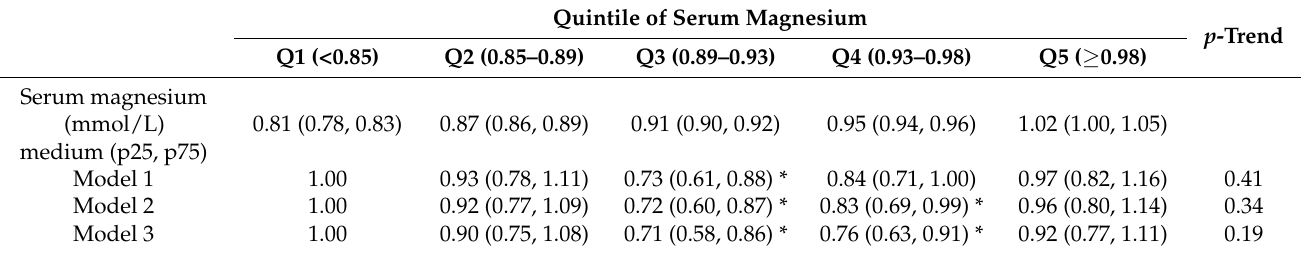
Table 2. Hazard ratio (HR) and 95% confidence interval (CI) for association between serum magne- sium quintiles and insulin resistance